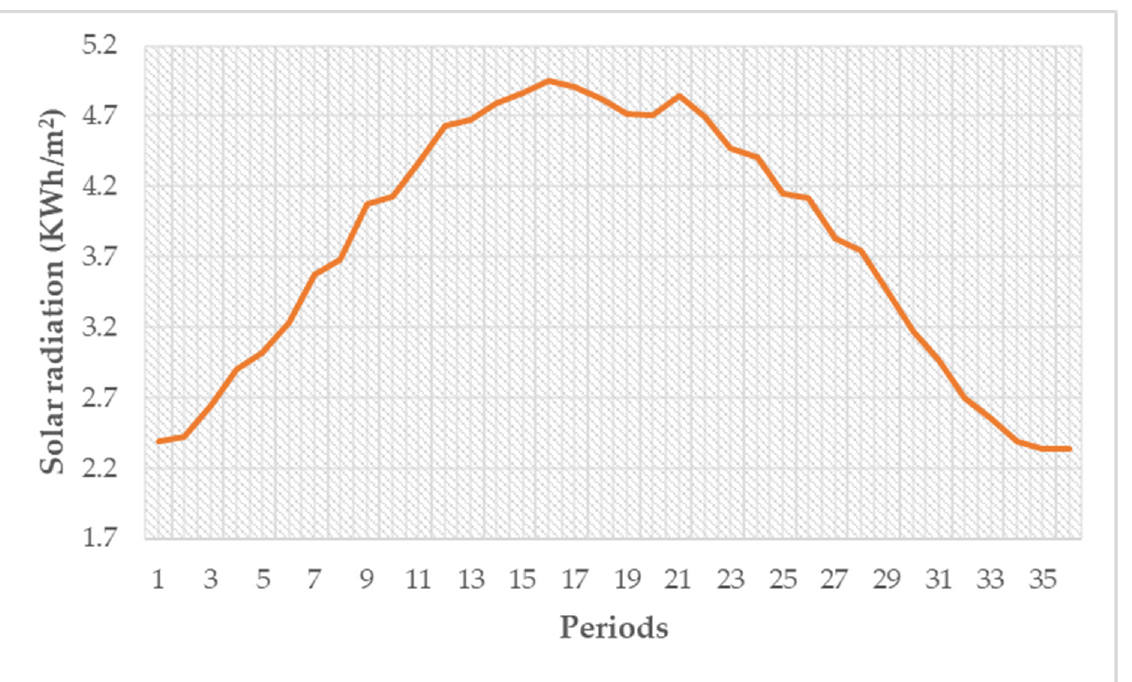
Figure 13. Change in 10-day average daily total PV energy in China for 36 periods .